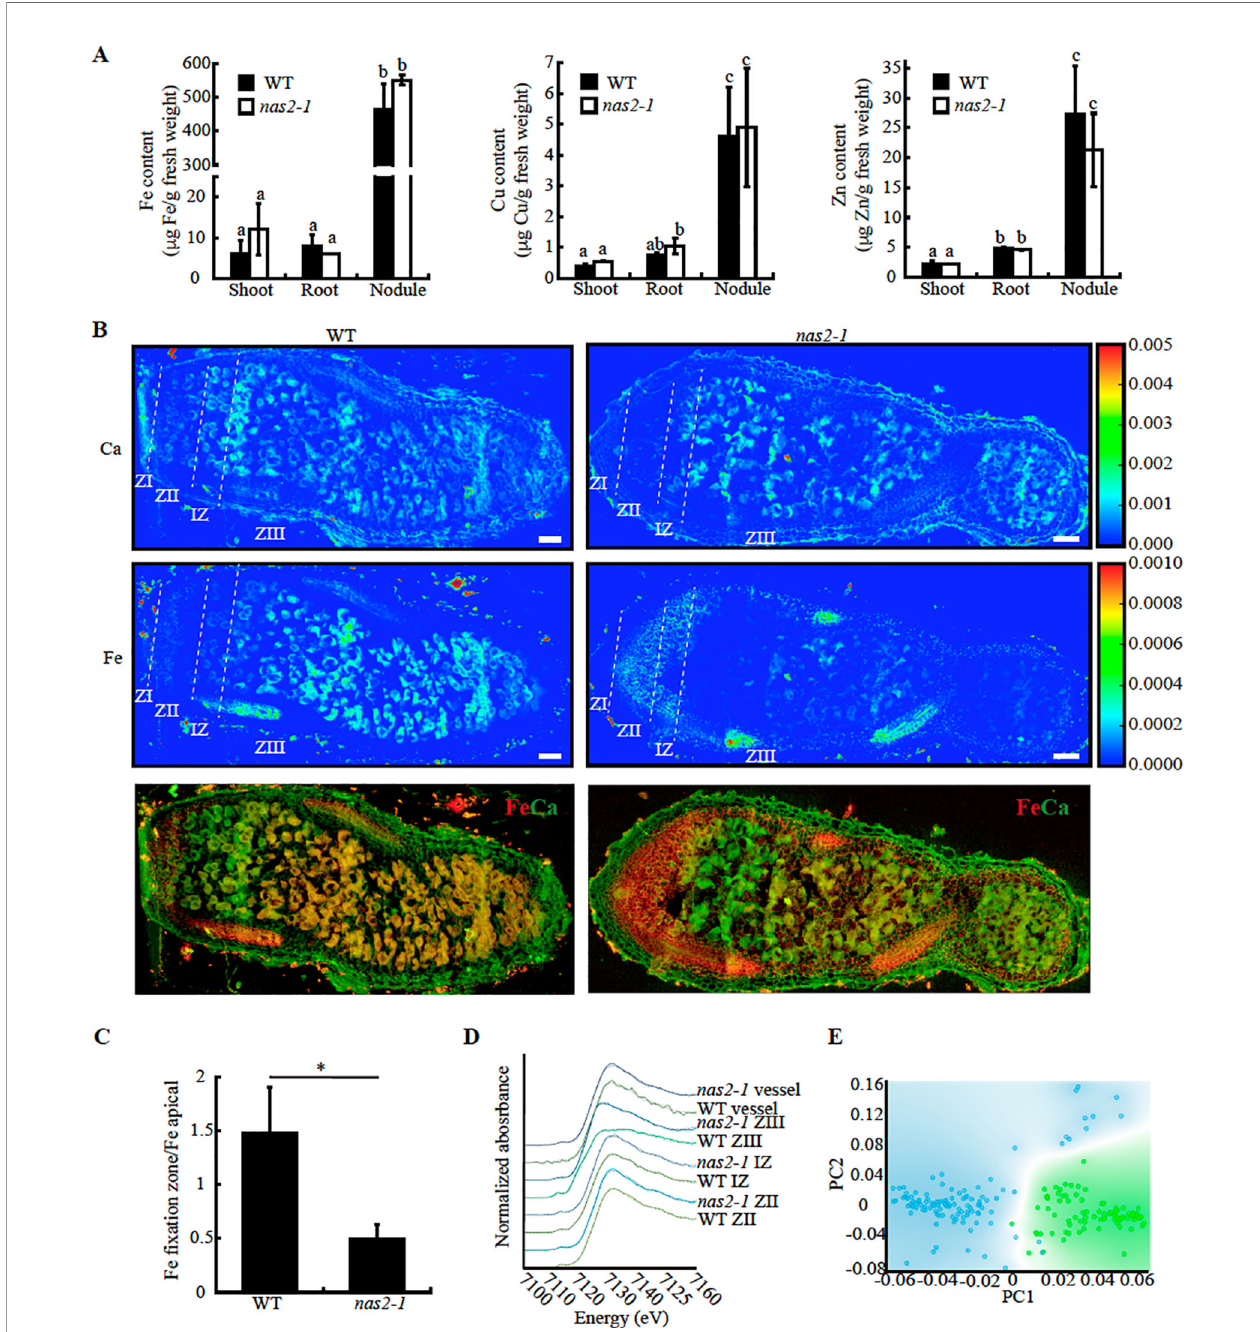
FIGURE 6 | MtNAS2 is required for iron distribution and speciation in nodules. (A) Iron (left panel), copper (middle panel), and zinc (right panel) concentration in shoots, roots, and nodules from 28 dpi wild-type (WT) and nas2-1 plants. Data are the mean ± SE of three sets of three-four pooled organs. Different letters indicate statistical differences at P < 0.05 (Tukey t-test). (B) Synchrotron-based X-ray fl uorescence images of WT (left panels) or nas2-1 (right panels) showing calcium (top panels) or iron (center panels) distribution in 28 dpi nodules. Lower panels are the overlaid iron and calcium distribution (iron is indicated in red and calcium in green). ZI indicates zone I; ZII, zone II; IZ, interzone; and ZIII, zone III (n = 5 – 7 nodules). Bars = 100 m m. (C) Iron content in fi xation zone relative to the apical zone in wild type and nas2-1 nodules. Data are the mean ± SE (n = 3). * indicates statistical differences at P < 0.05 (Student t-test). (D) XANES spectra obtained from different regions of WT and nas2-1 nodules. (E) Decomposition of the zone III signal into its two principal